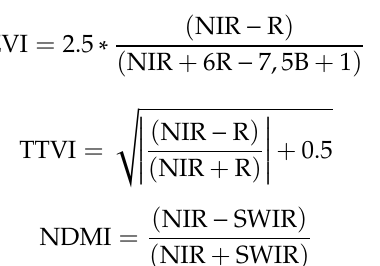
Figure 2. Types of plots classified according to the type of coverage: ( a ) not-in-production plot, ( b ) in-production plot and ( c ) abandoned plot.